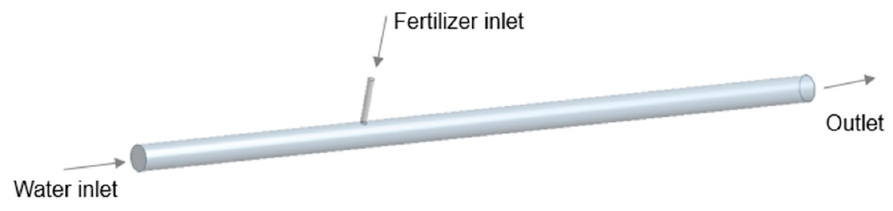
Figure 1. The water and fertilizer mixing pipe model.